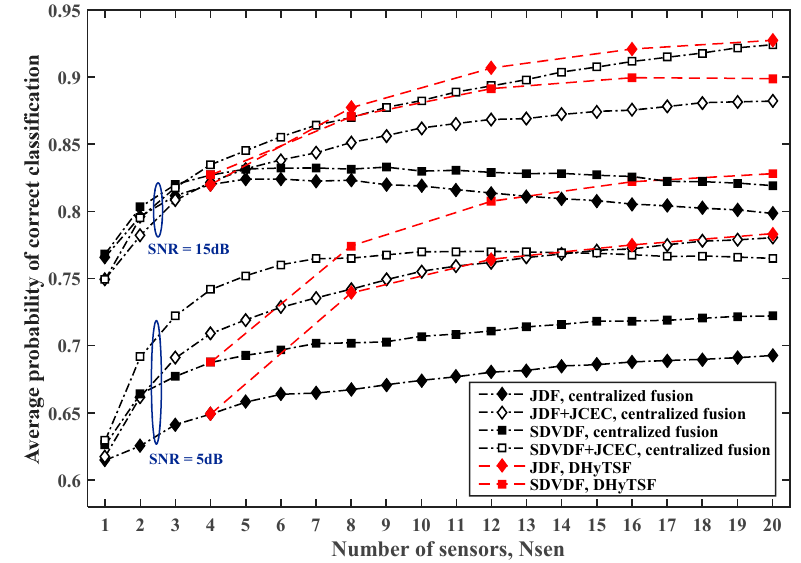
Figure 10. The estimated P CC , avg value for the centralized and distributed cooperative MC in SNS2, for N S = 500 and L max = 10.